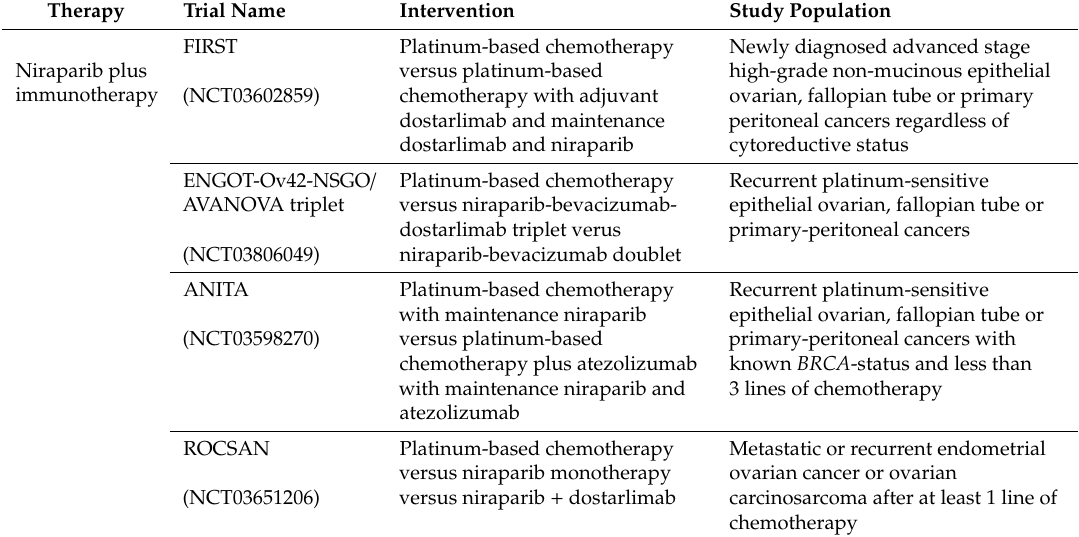
Table 4. Ongoing phase 3 trials of niraparib monotherapy or combination